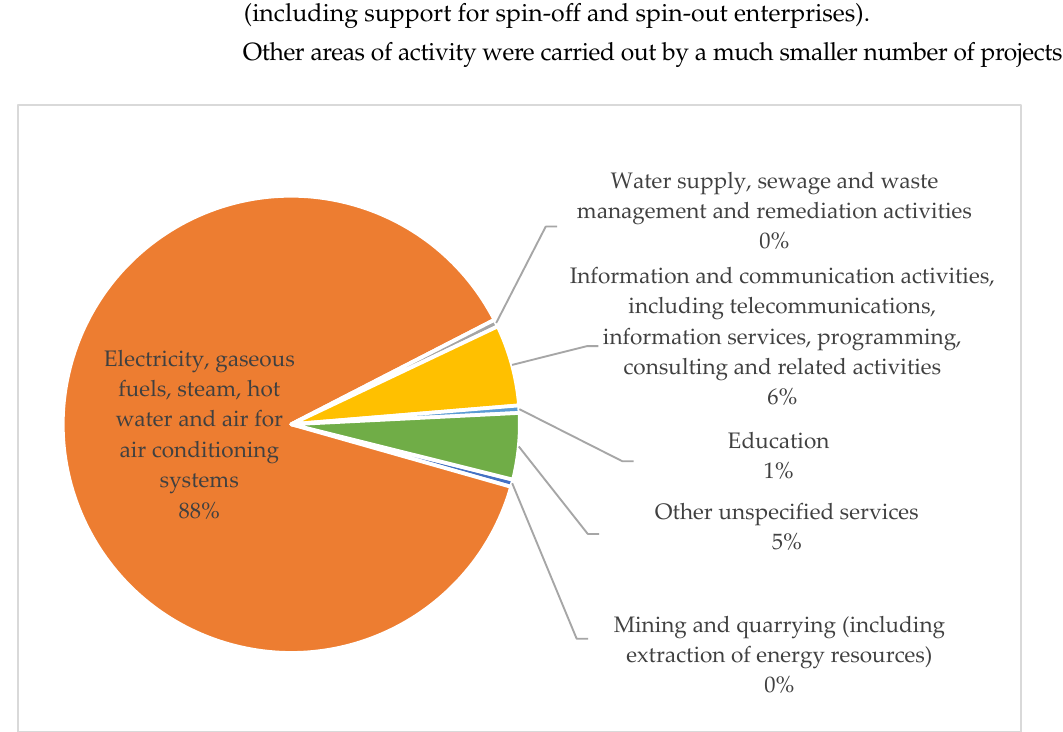
Figure 1. Share of ongoing projects within the fields of activity. Source: own elaboration based on data from www.funduszeeuropejskie.pl (accessed on 10 March 2022).